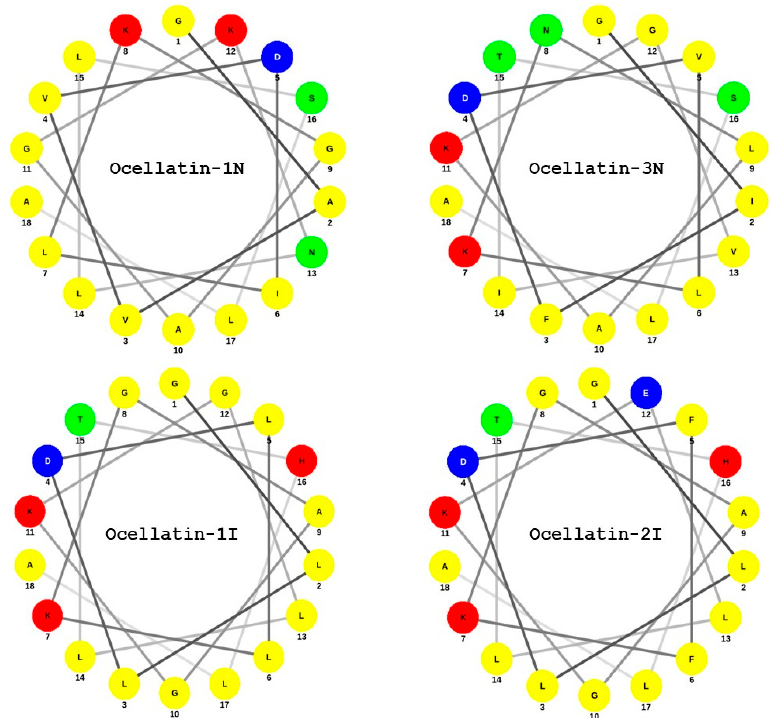
Figure 6. Schiffer–Edmundson wheel representation of the (1–18) regions of four of the ocellatins, isolated from L. insularum and L . nesiotus . Amino acid color code: Red—polar/basic (Lys, His); blue—polar/acid (Asp, Glu); green—polar/uncharged; and yellow—nonpolar/hydrophobic.